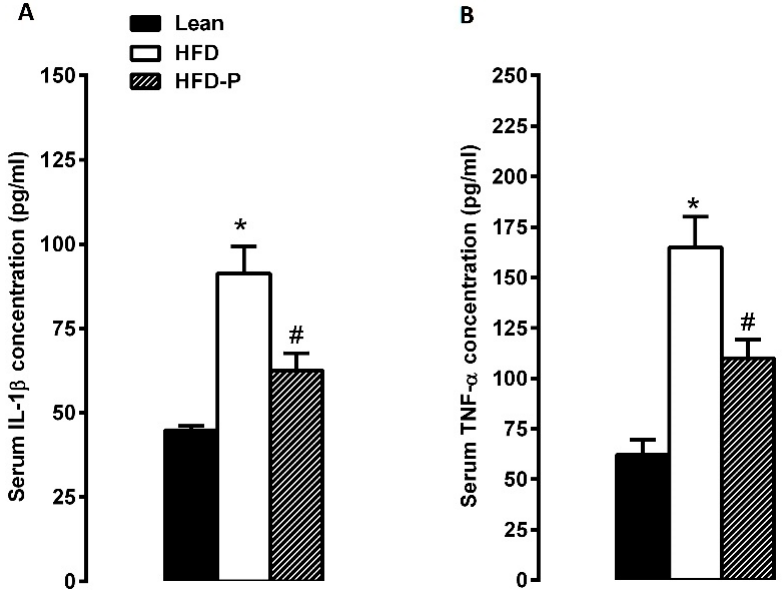
Figure 1. E ff ects of pistachio consumption on pro-inflammatory cytokines. Serum circulating levels of IL-1 β ( A ) and TNF- α ( B ) in the lean, HFD, and HFD-P groups. Data are expressed as mean ±